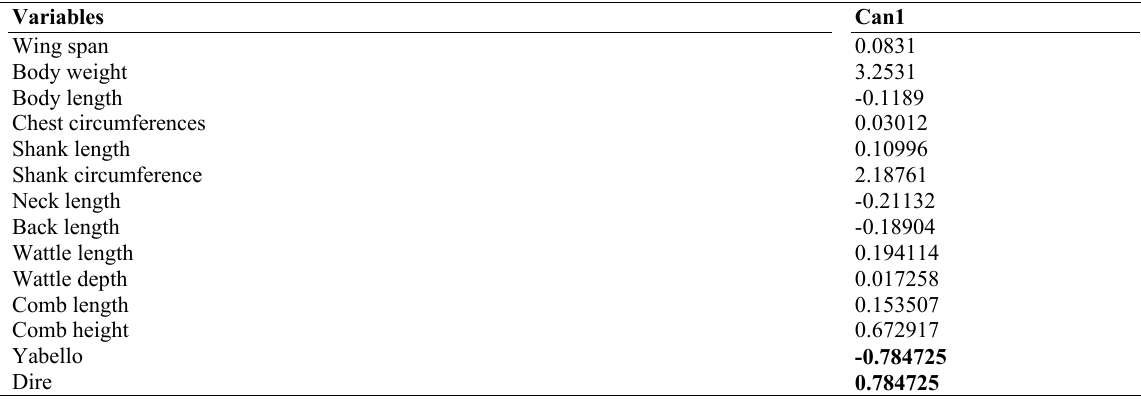
Table 8. Total sample standardized canonical coefficients and canonical